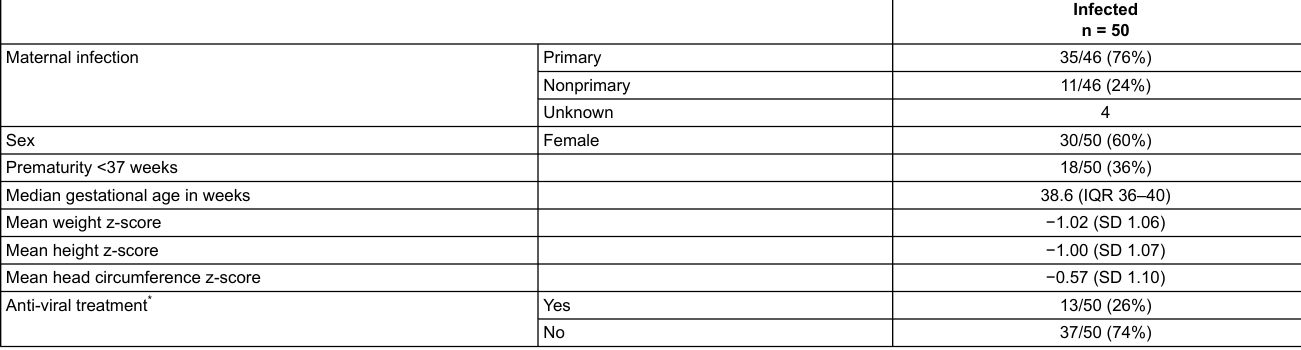
Table 1: Baseline characteristics at birth of all newborns with congenital cytomegalovirus